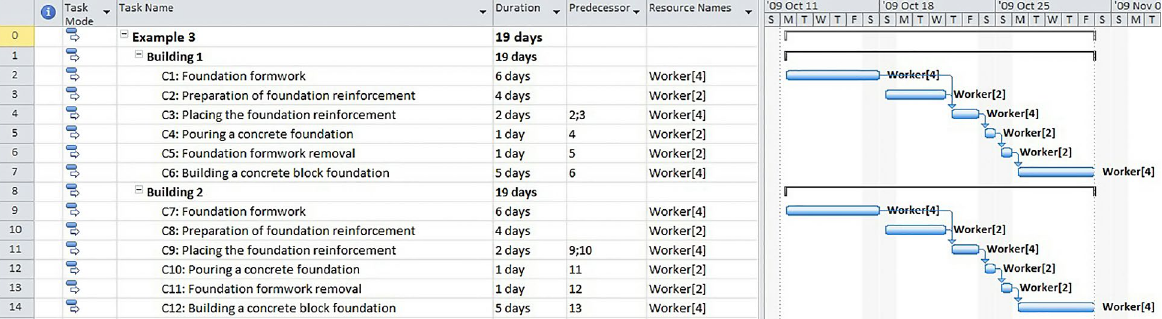
Fig. 7. A solution for example 3 using MSP